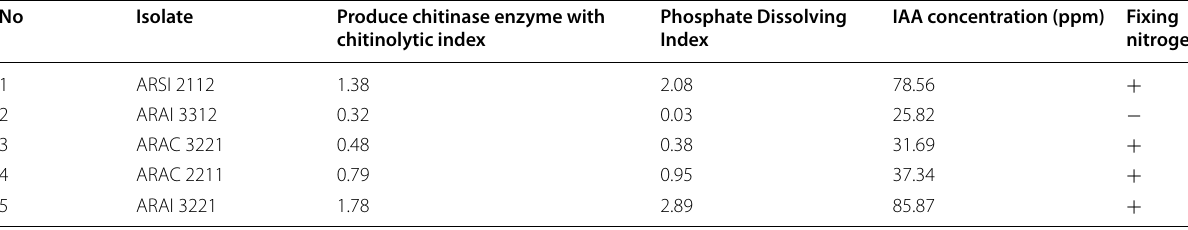
Table 4 Ability of actinobacteria to produce chitinase enzymes, dissolve phosphate, produce IAA, and fix nitrogen No Isolate